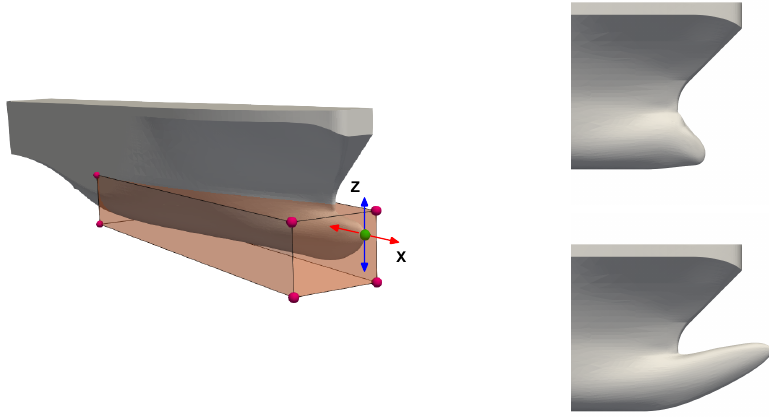
Figure 2. Left: undeformed geometry. The green sphere represents the control point used to deform the geometry; this control point can move in the plane XZ. The surface region within the selection box is free to deform. Right: two deformed